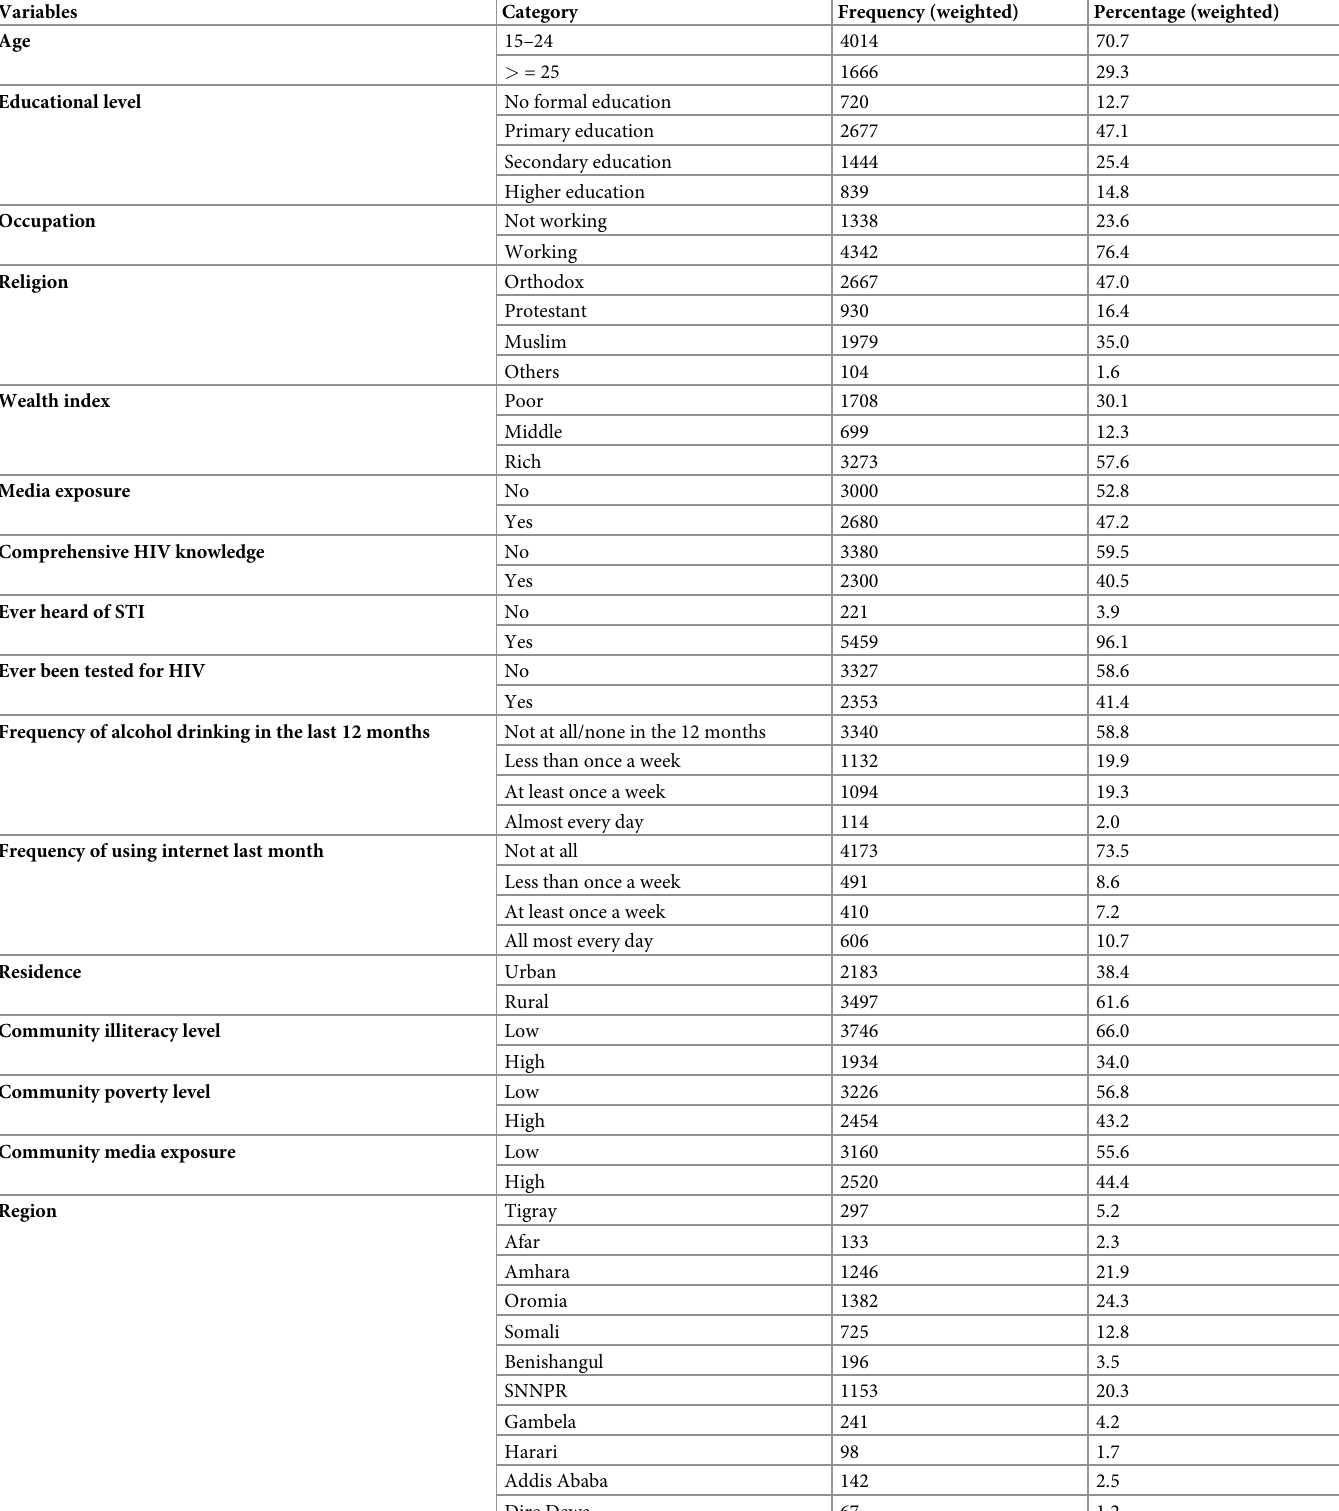
Table 1. Sociodemographic and community-level characteristics of unmarried men in Ethiopia,